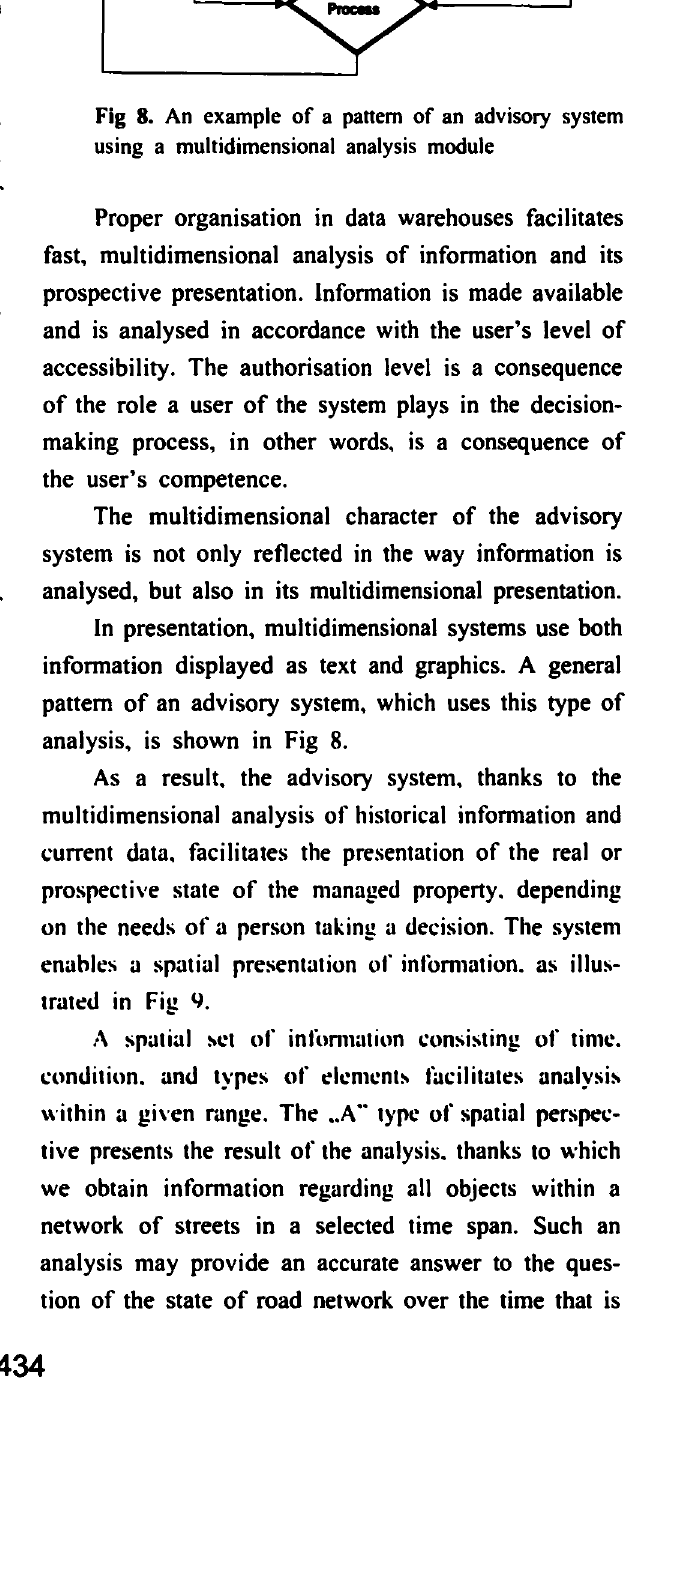
Fig 7. Cross and longitudinal sections resulting from multidimensional analysis of string model